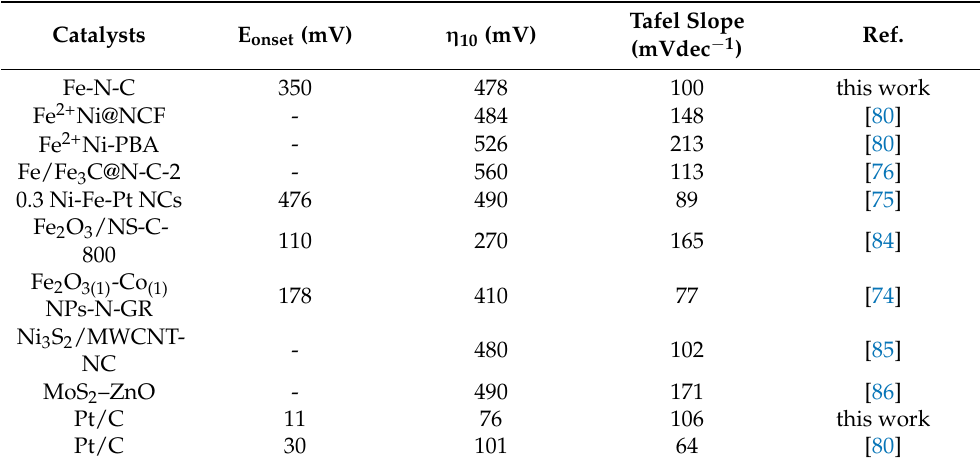
Table 2. HER parameters at a current density of − 10 mAcm − 2 for the synthesized Fe-N-C material and other PGM and PGM-Free catalysts reported in